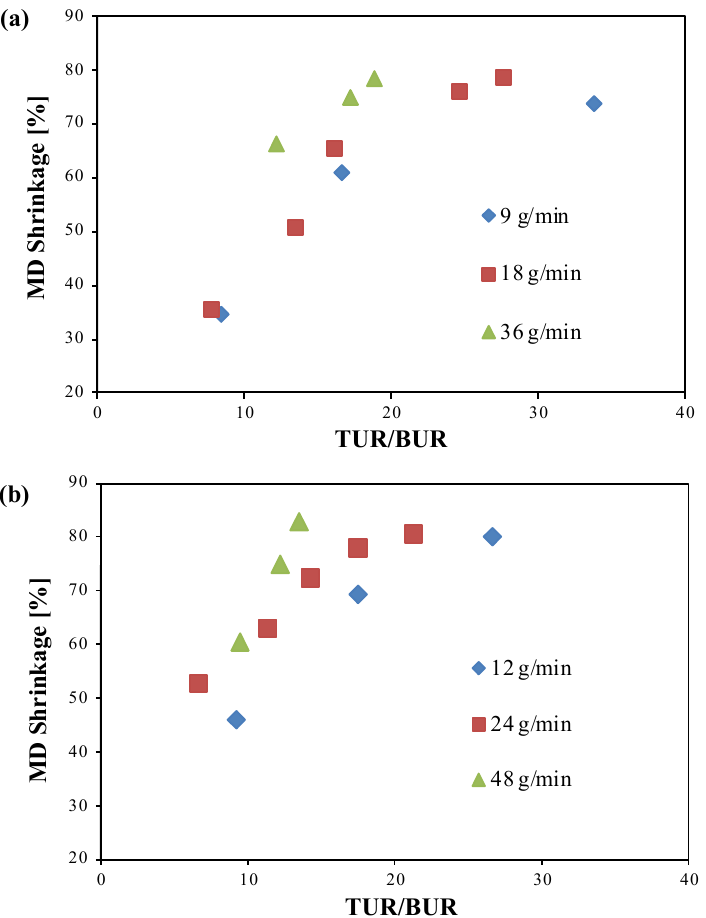
Figure 1. Percentage of shrinkage in MD versus TUR/BUR for ( a ) PLA40 and ( b ) PLA60 films, obtained with cooling air.